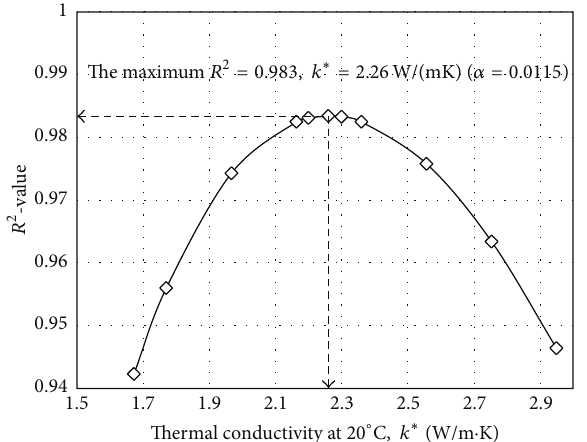
Figure 8: Regression analysis to identify 𝛼 giving the maximum 𝑅 2